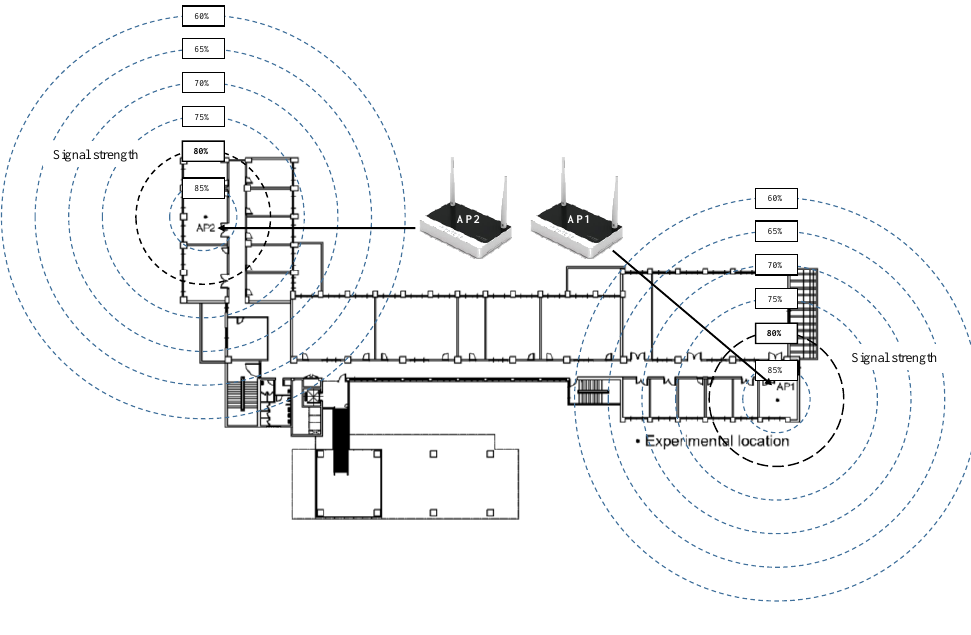
Figure 7. Experimental location (second floor).